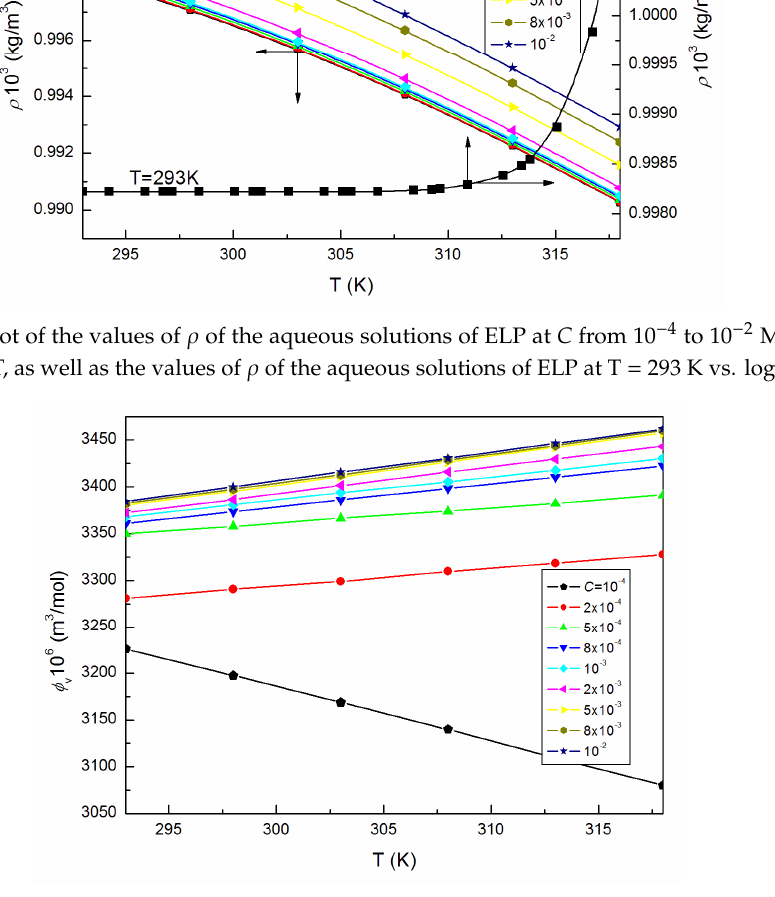
, of the aqueous solutions of ELP at V